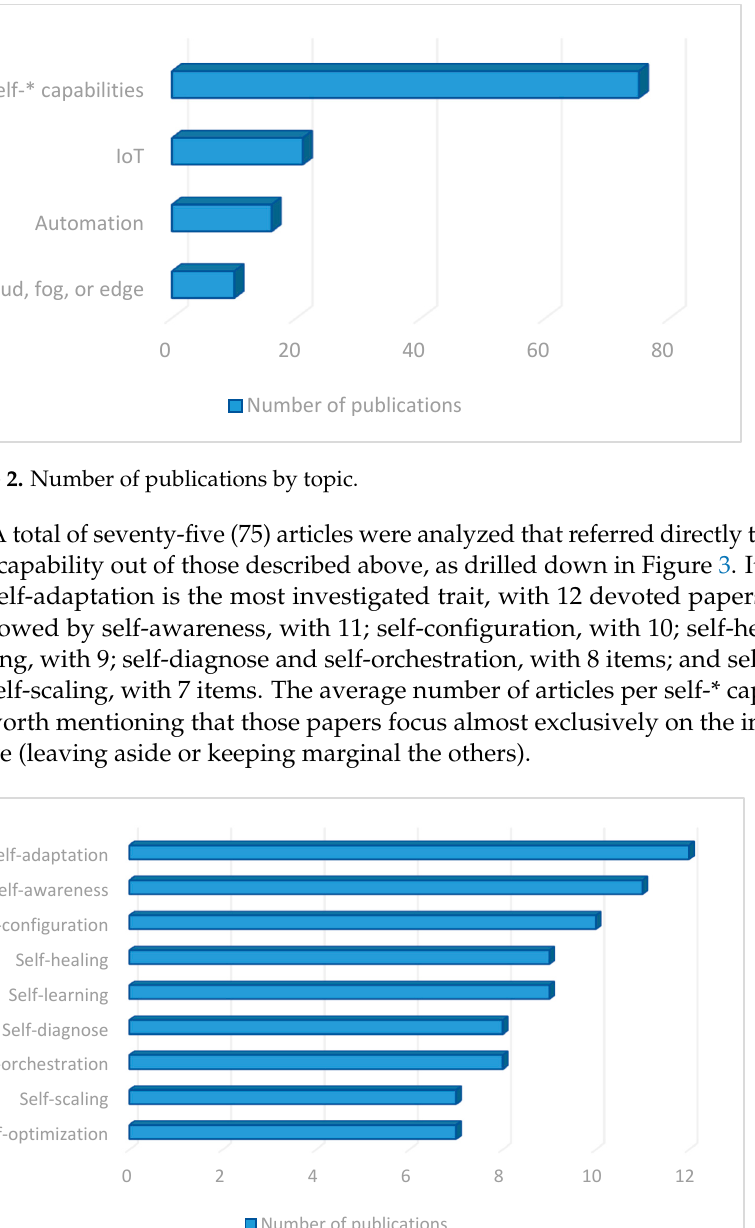
Figure 1. Number of publications before and after 2015.